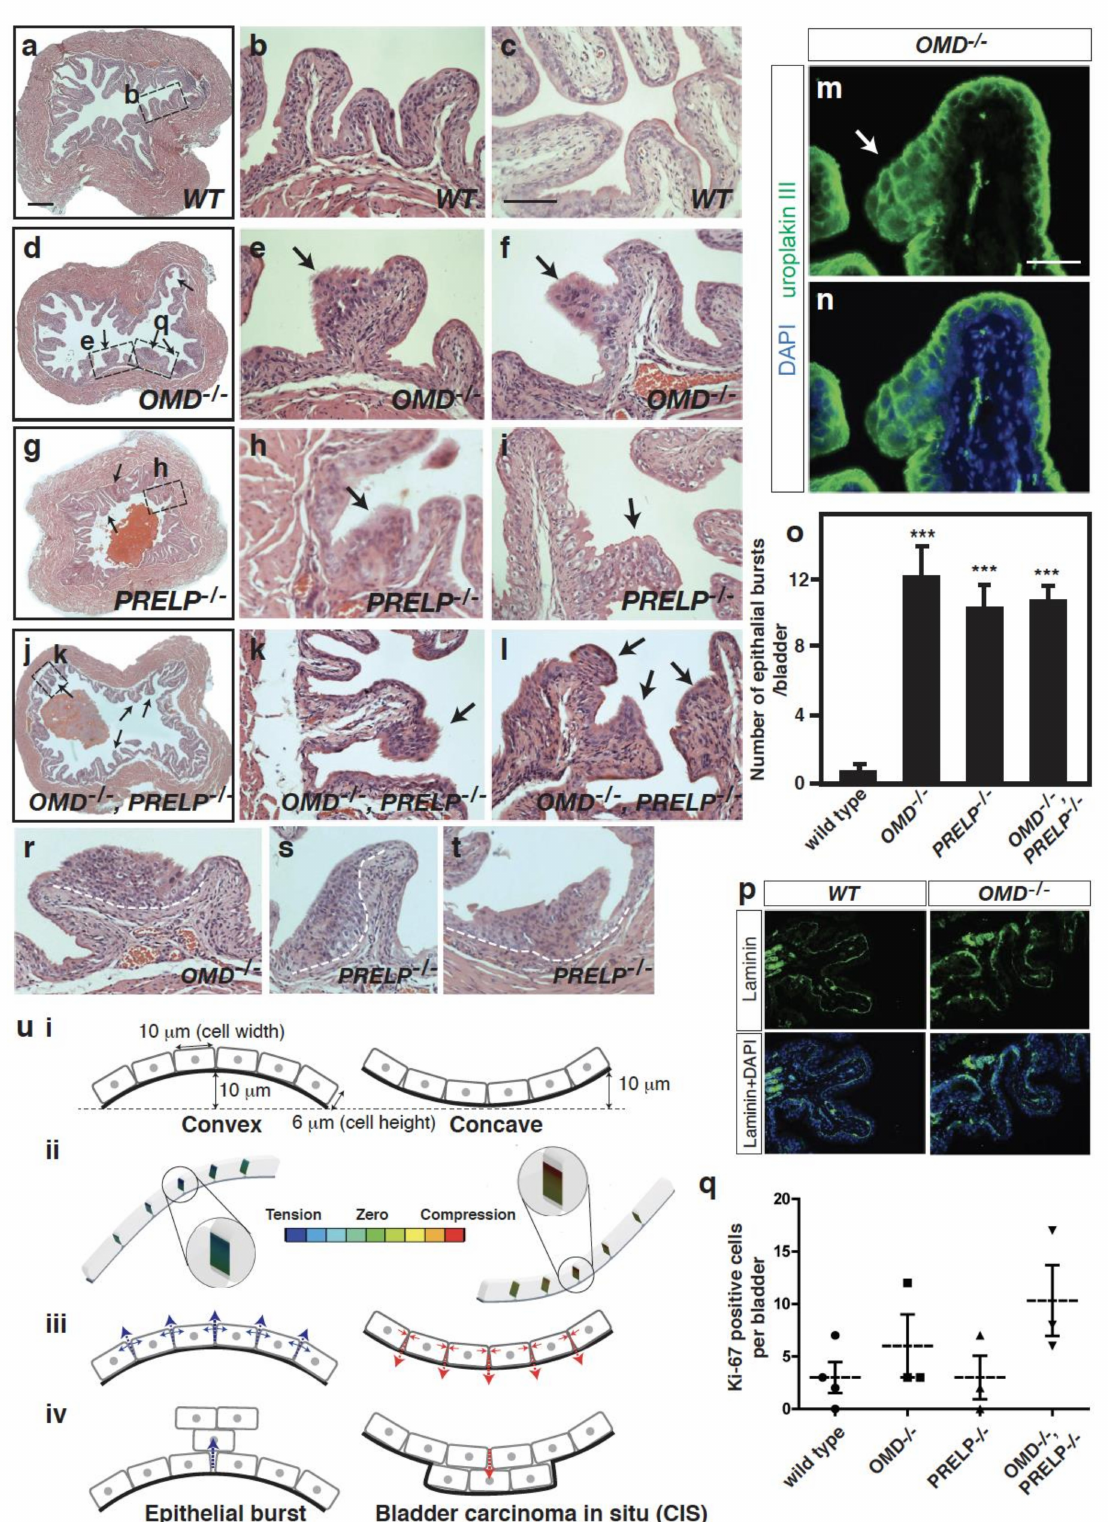
Figure 9. OMD − / − , PRELP − / − , and their double knockout mice spontaneously initiate bladder papillary cancer. ( a – l ) 3-month-old bladder of WT ( a – c ), OMD − / − ( d – f ), PRELP − / − ( g – i ), and their double knockout ( j – l ). A low magnification and two high magnification images are shown in order. Epithelial bursts are indicated as arrows. Some enlarged areas are indicated as boxes in low-magnification images. Scale bar represents 500 µ m ( a , d , g , j ) and 100 µ m ( b , c , e , f , h , i , k , l ). ( m – o ) Uroplakin III antibody